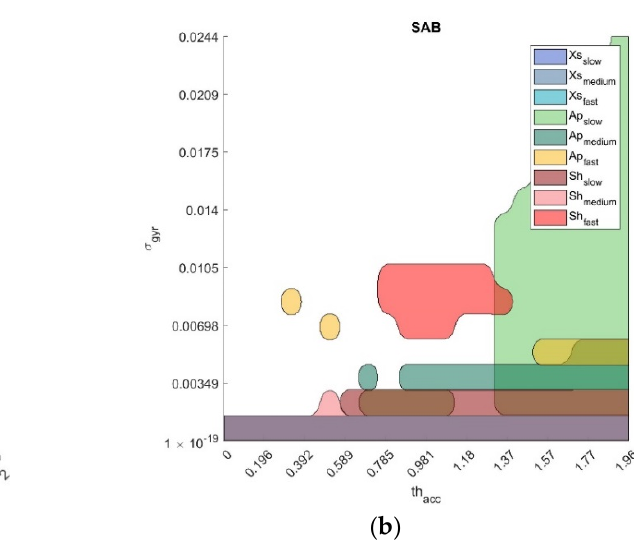
Table A5. Sensor Specifications. Reprinted with permission from ref. [31]. Copyright 2020 IEEE.